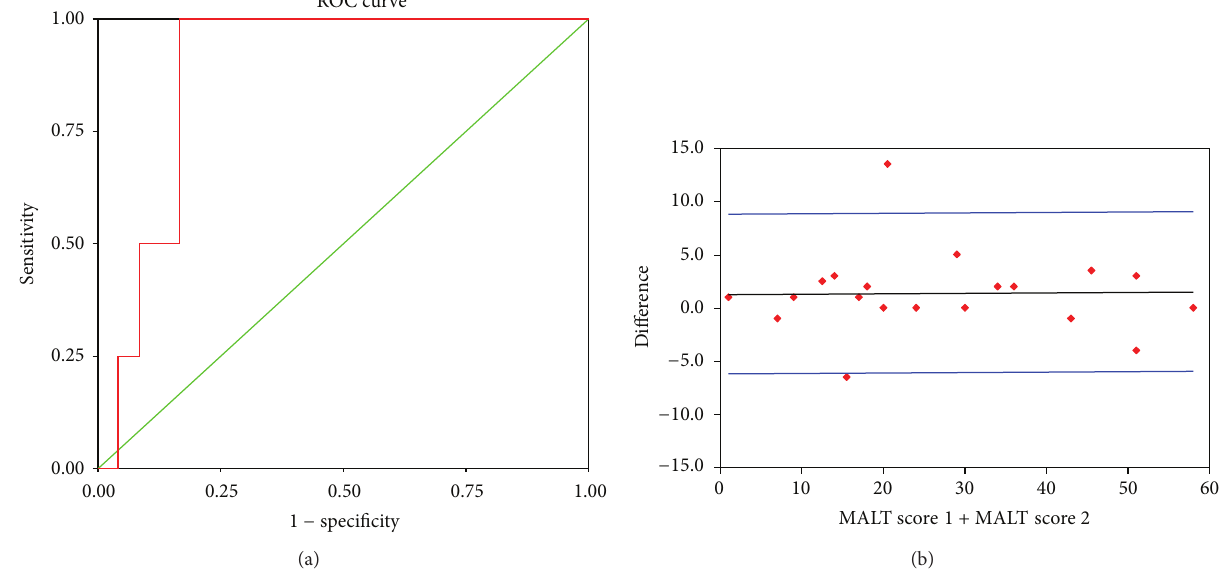
Figure 4: (a) ROC curve using CFF as gold standard and MALT score 20 as cut-off for the diagnosis of MHE. (b) Bland-Altman plot for the test-retest agreement of